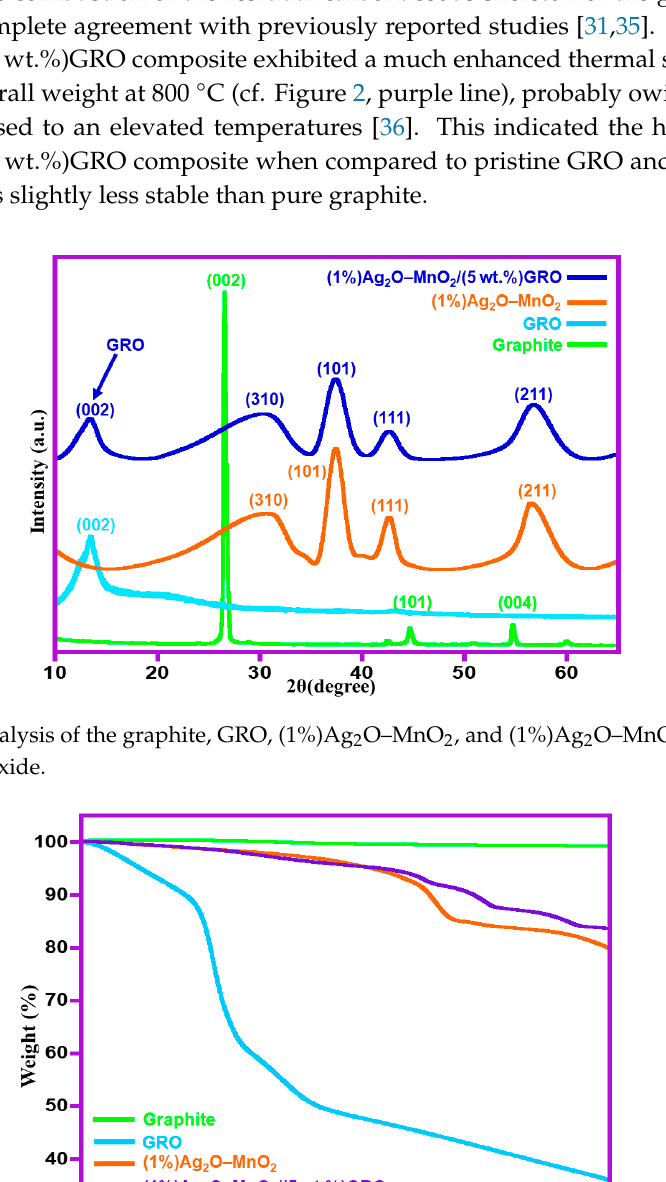
Figure 2. TGA graphs of the graphite, GRO, (1%)Ag 2 O–MnO 2 , and (1%)Ag 2 O–MnO 2 / (5